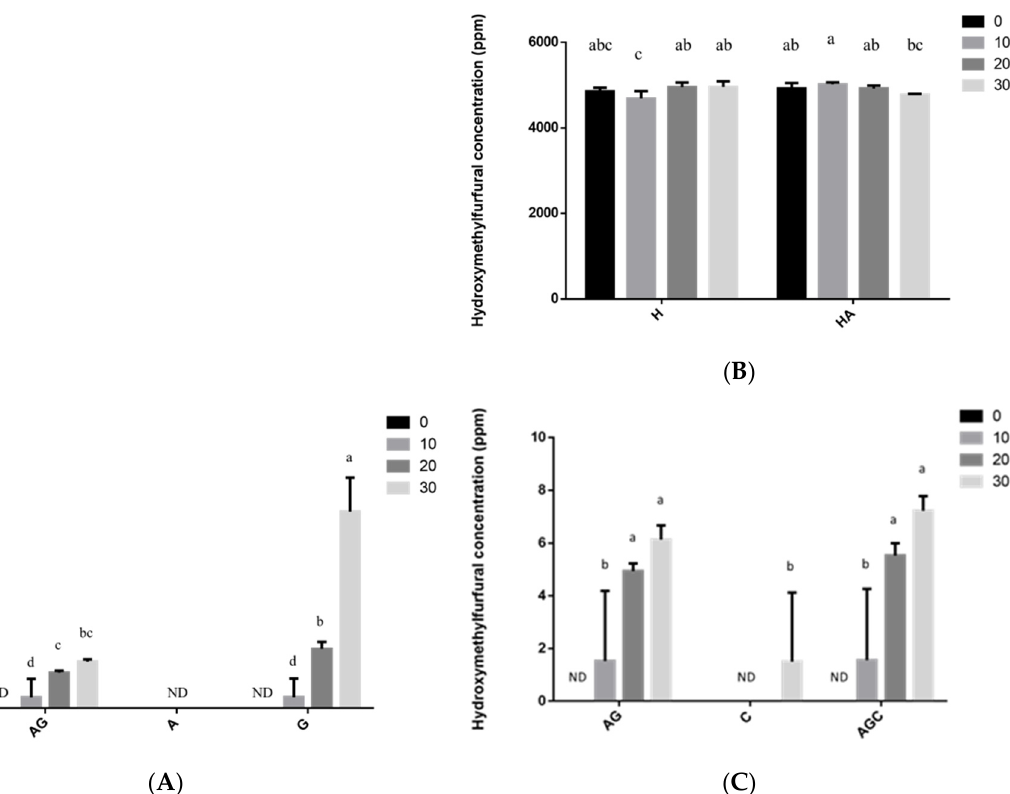
Figure 3. Amounts of acrylamide (ppb) between different groups in: ( A ) deionized water and ( B ) acetic acid at various heated processing duration. AG: asparagine + glucose; A: asparagine; G: glucose; H: hydroxymethylfurfural; HA: hy- droxymethylfurfural + asparagine; C: chitosan; AGC: asparagine + glucose + chitosan. ND: Not Detected. Values are ex- pressed as mean ± standard deviation (SD) (n = 3). a–d Indicate significant differences between different groups ( p < 0.05).